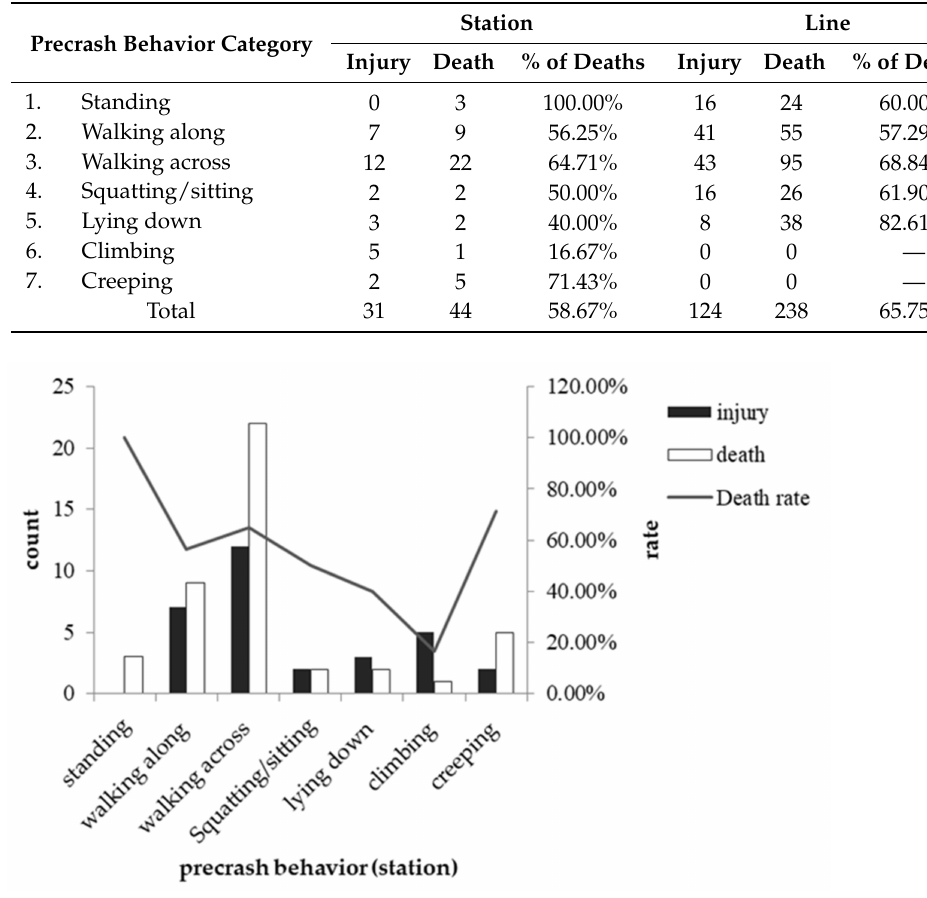
Figure 7. Occurrence of different crash severities by different precrash behaviors in the